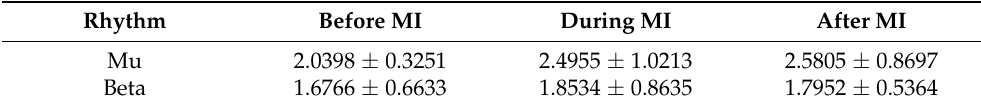
Table 2. Variation of average characteristic path length in three states of motor imagery in mu/beta